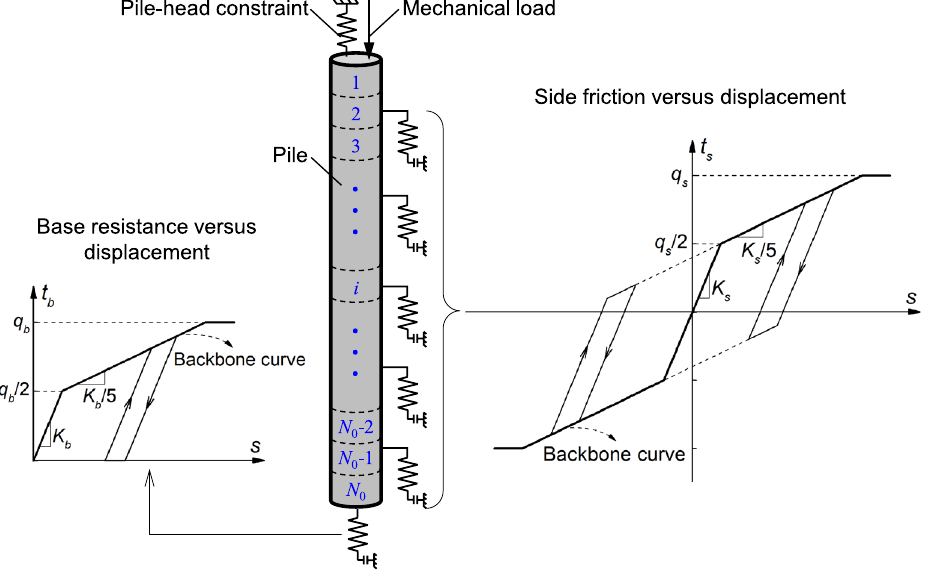
Figure 1. Illustration of load-transfer model for energy